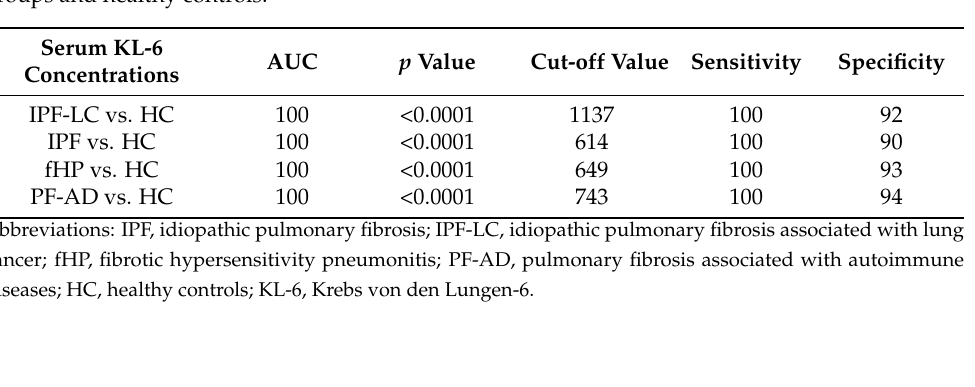
Figure 2. Receiver operating characteristic (ROC) curve analysis distinguished IPF and IPF-LC patients (AUC 92%; 95% CI 78–100; p = 0.0005), indicating a best cut-off value of 1370 U/mL (83% sensitivity, 92% specificity). Table 1. Main characteristics of our study population including age, gender, smoking habit, BMI, LFT parameters, and KL-6 serum concentrations. All data were expressed as median and interquartile range (IQR). Parameters